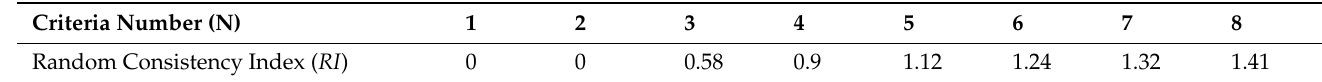
Table 6. Average random consistency indices for different numbers of criteria [4].